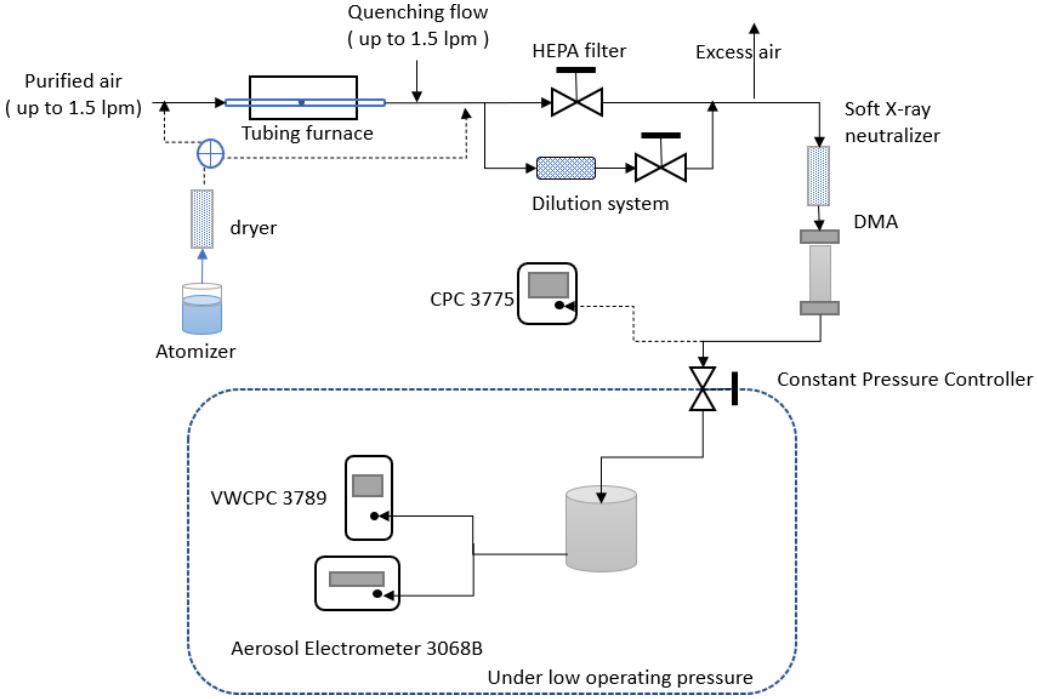
Figure 2. Schematic of the vWCPC 3789 sensors and flow system under the low-pressure testing.